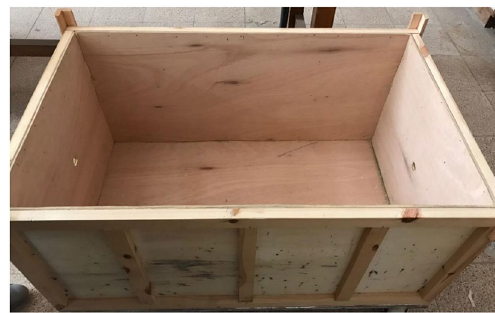
Fig. 3 Lower section of an isolated wooden box